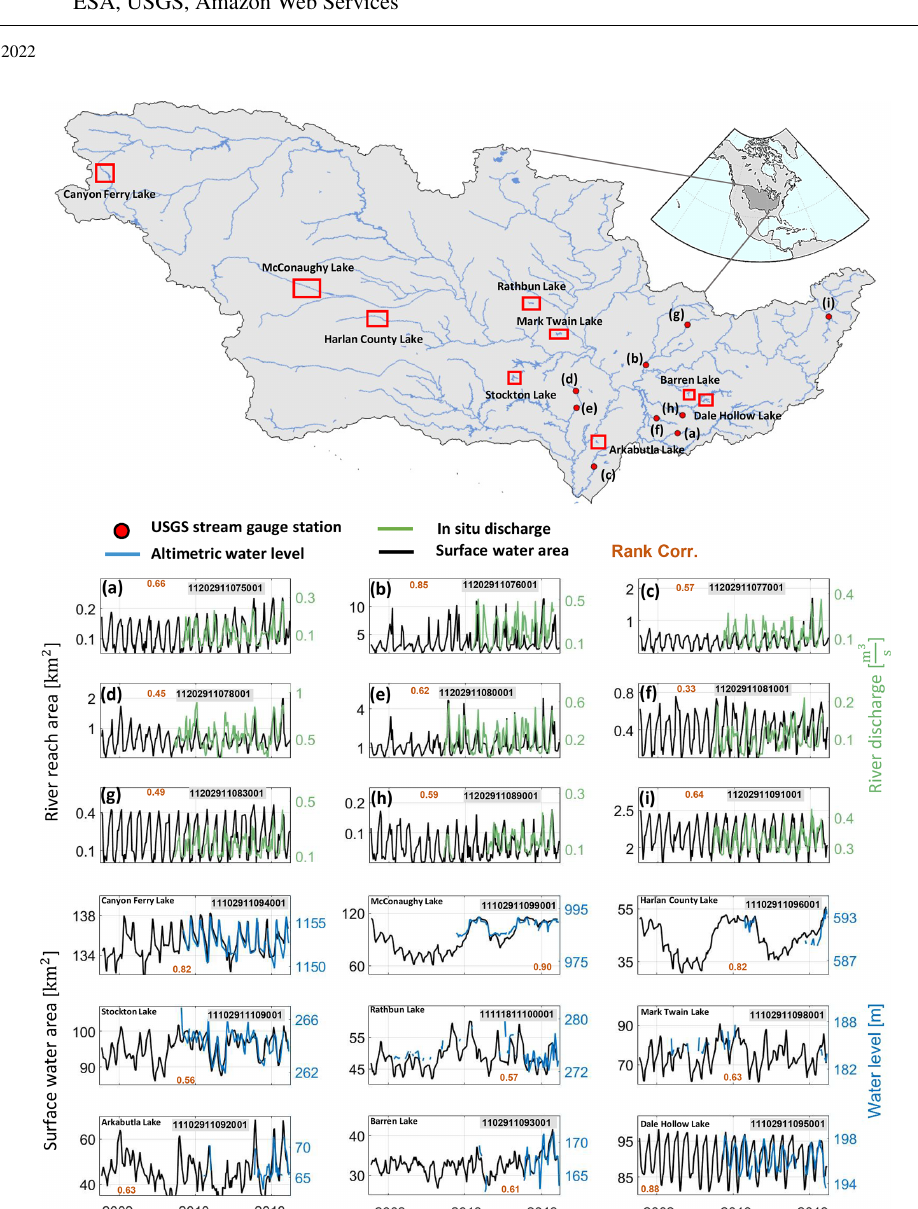
Figure 4. Time series of river reach area of selected river reaches in the Mississippi River basin are in the middle panel.